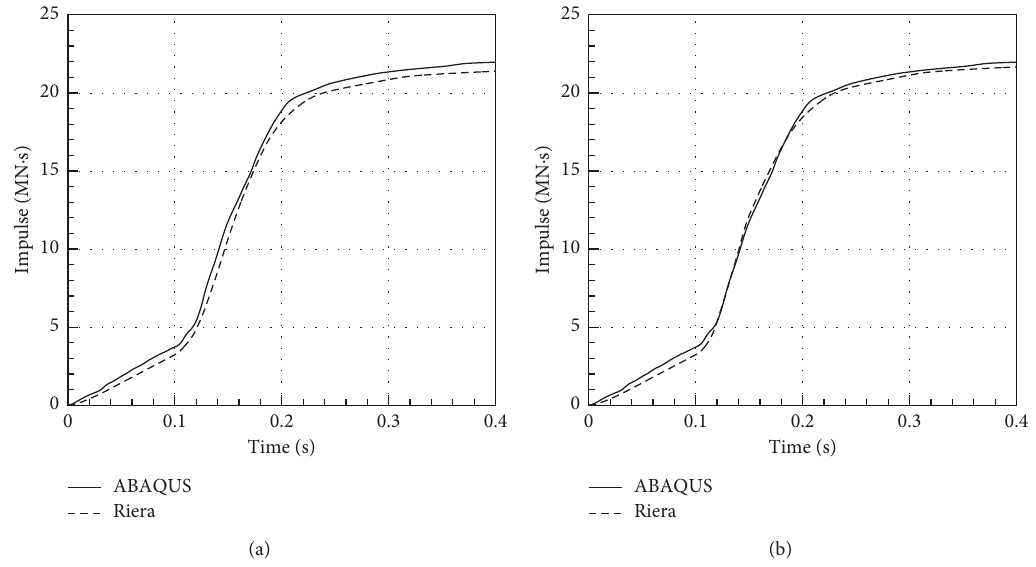
Figure 5: Impulse-time history results of Boeing 767-200ER. (a) WT case. (b) CT